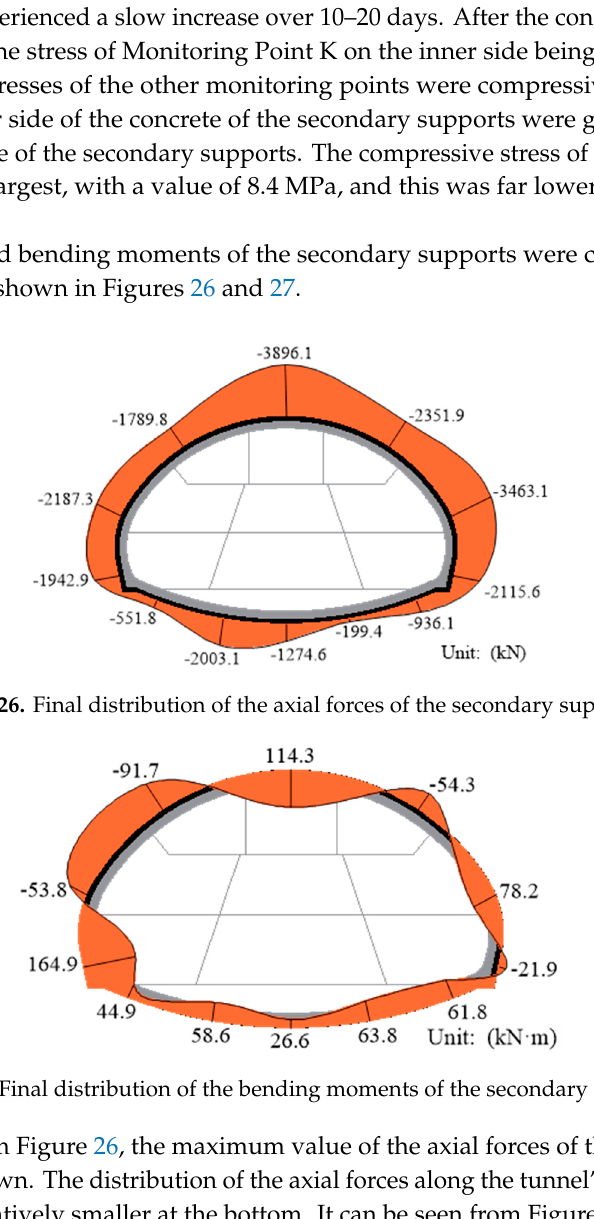
Figure 27. Final distribution of the bending moments of the secondary supports.